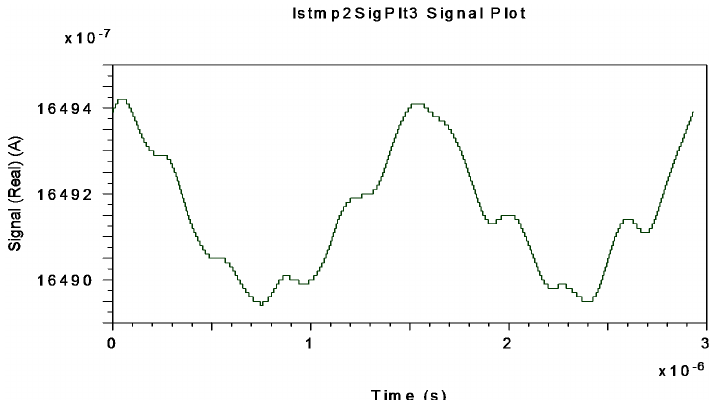
Figure 12. Interferometric current signal obtained at APD-equivalent-photodetector electrical output (after electrical BP Filter with f center = 340.83 kHz) when Ω = ±10 °/s is applied to system.